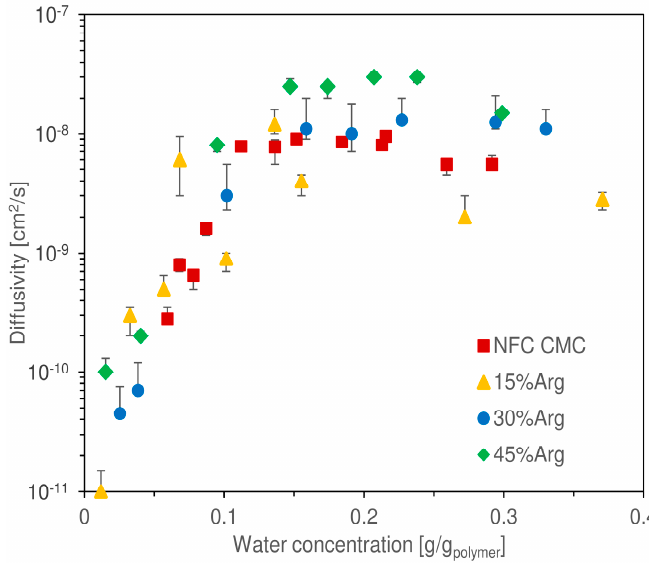
Figure 8. Fickian diffusion coefficient of CMC-NFC films with different loadings of arginine at 35